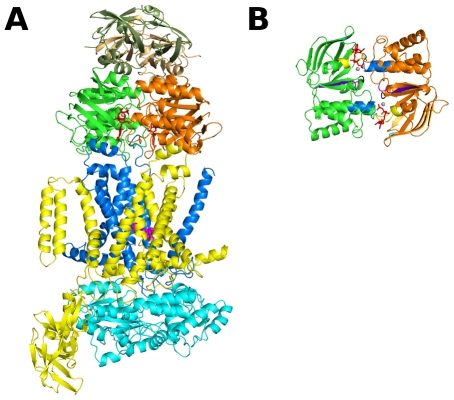
Crystallographic structure for the ATP-bound MalFGK2E complex (PDB code: 2R6G) [21].The NBD1 and the NBD2 (named MalK1 and MalK2) are colored in green and orange respectively, while the TMD1 (called MalF) is yellow, the TMD2 (named MalG) is blue and the maltose binding protein (called MalE) is cyan. ATP is represented by red sticks, the magnesium cofactors as gray spheres and the maltose molecule is represented by magenta spheres. All figures were generated with the program PyMOL [99]. A- View of the MalFGK2E complex. In this image, the regulatory domains are colored in lighter green and orange. B- Rotated (90°) view of the MalK dimer. The conserved sequence family motifs are colored: Q-loop (magenta), ABC signature (blue), P-loop (yellow), A-loop (cyan), Walker-B (purple) and H-motif (black). For clarity purposes, the regulatory domains are not represented in this image.